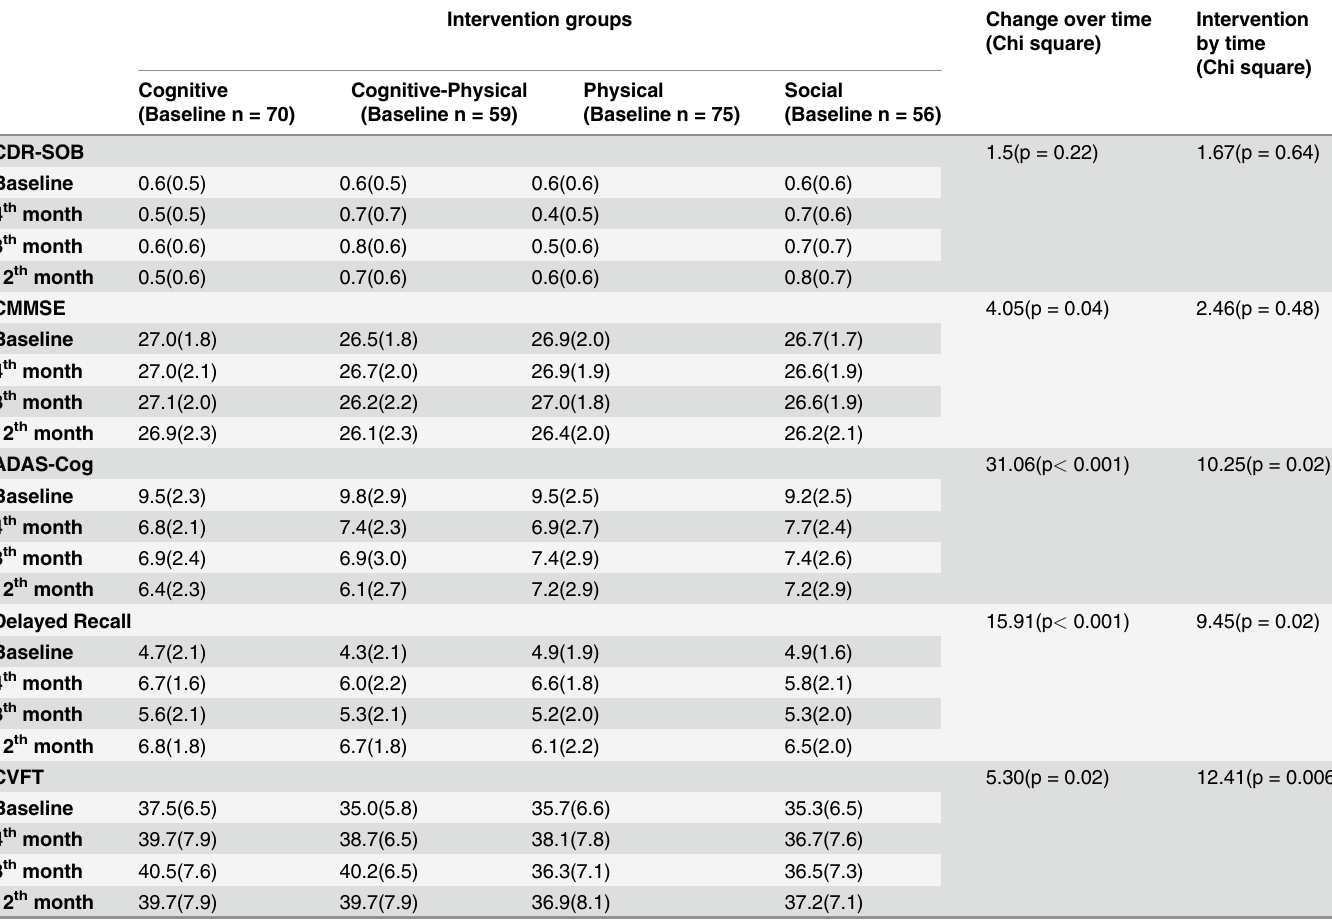
Table 4. Effects of activity intervention on cognitive and mood outcomes for participants with MCI-single domain deficit (Intention-to-treat method).